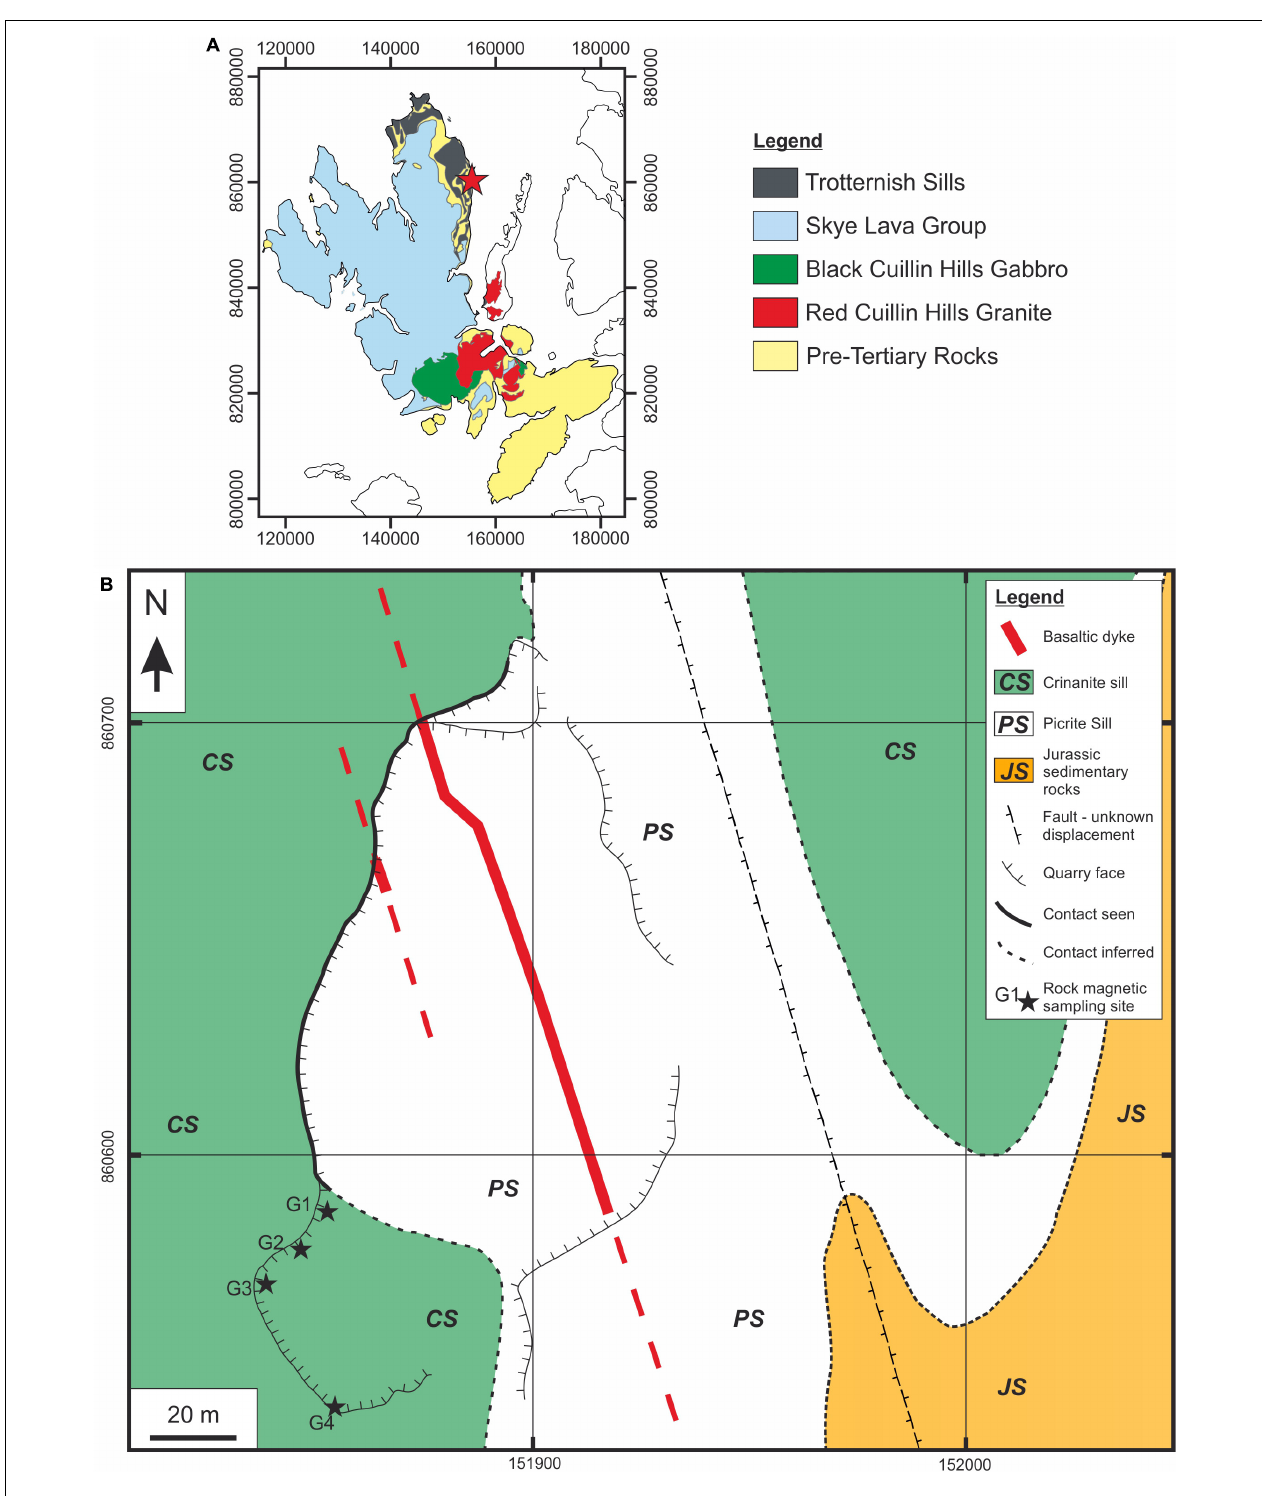
FIGURE 1 | (A) Simplified geological map of the Isle of Skye (modified after EDINA Geology Digimap Service, 2008) showing location of Inver Tote (Red Star). (B) Geological map of disused quarry near Inver Tote, Isle of Skye, Scotland. Palaeogene age crinanite (CS) and picrite sills (PS) (green and white respectively) of the Little Minch Sill Complex, British and Irish Palaeogene Igneous Province, have intruded Jurassic sedimentary rocks (JS, orange). Cross cutting the area are two basaltic dykes (red). Locations of magnetic sampling sites are marked G1-4 in the SW end of the quarry.